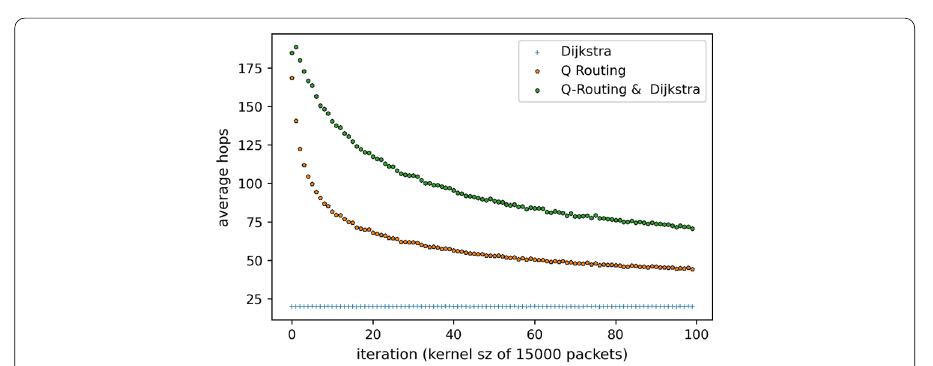
Fig. 11 Packets hop number with three